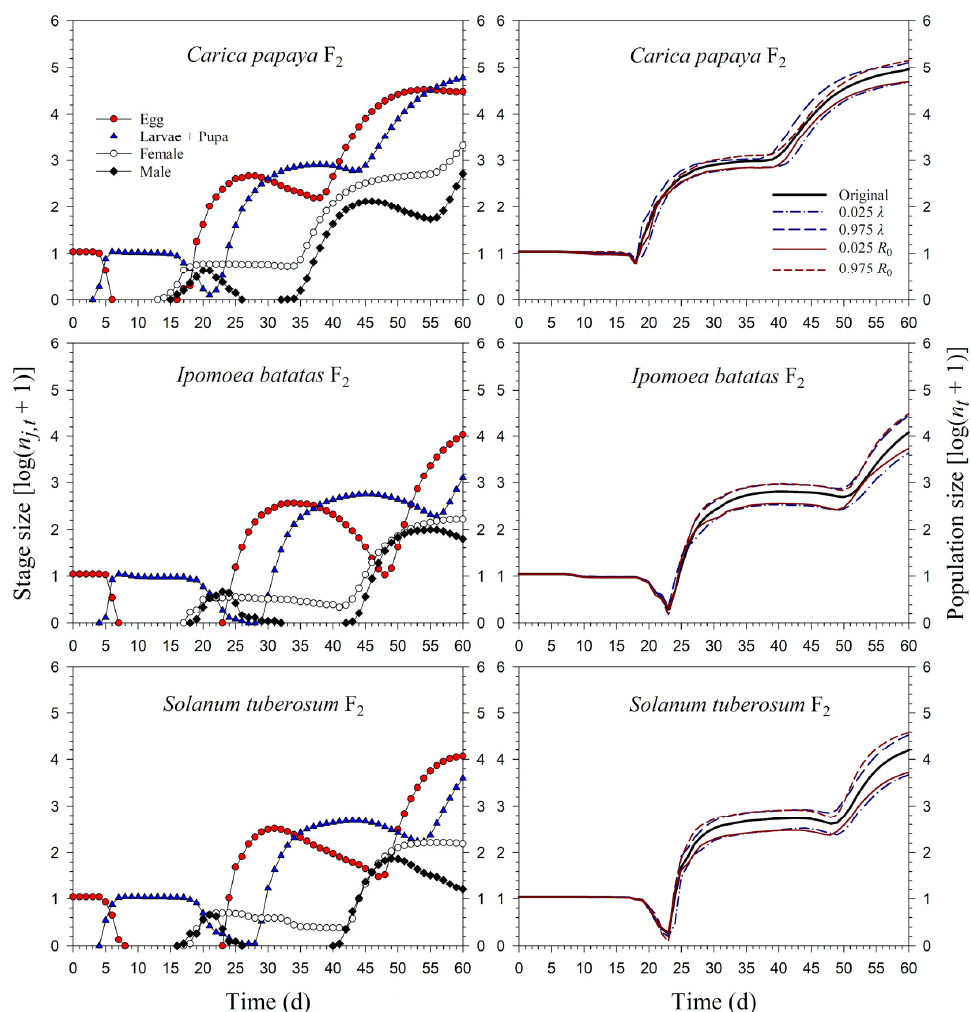
Figure 7. Stage size (log ( n j , t + 1)) and population size (log ( n t + 1)) rates of Paracoccus marginatus individuals reared on three different host plants (F 2 ).